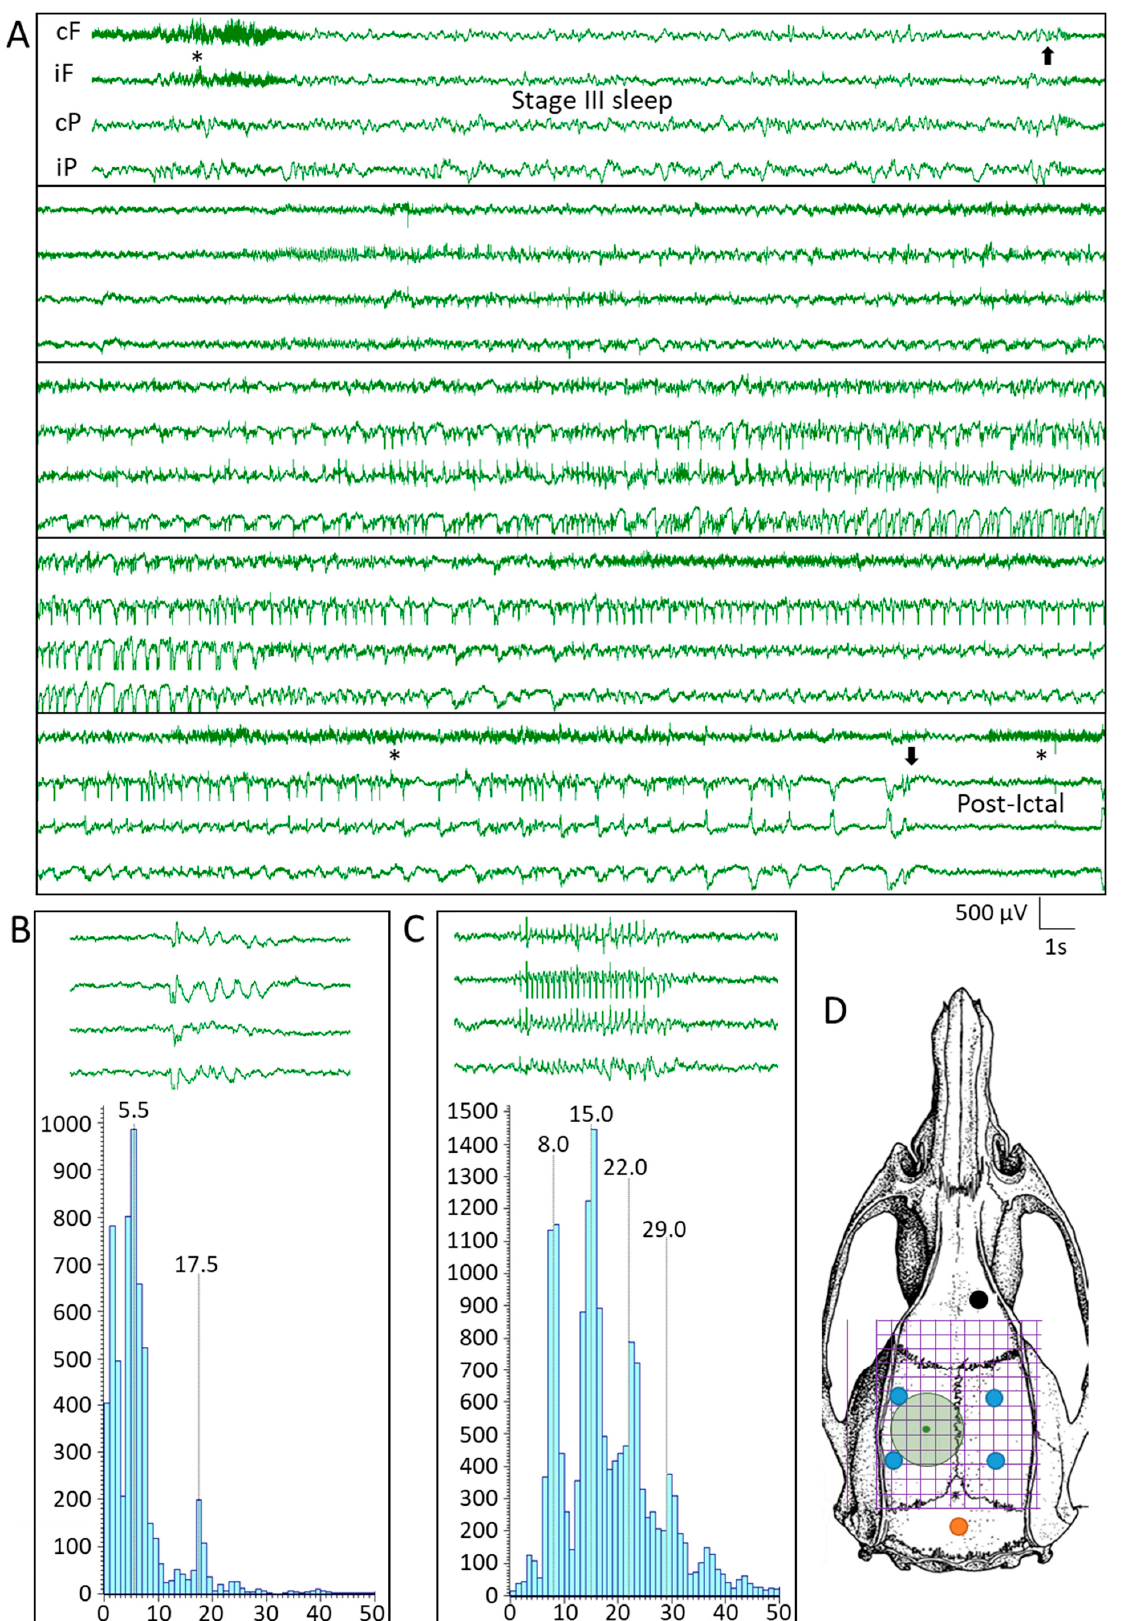
Figure 3. Video-electroencephalogram (vEEG) analysis. ( A ) A spontaneous seizure in a rat (#22) from the TBI FI -Veh